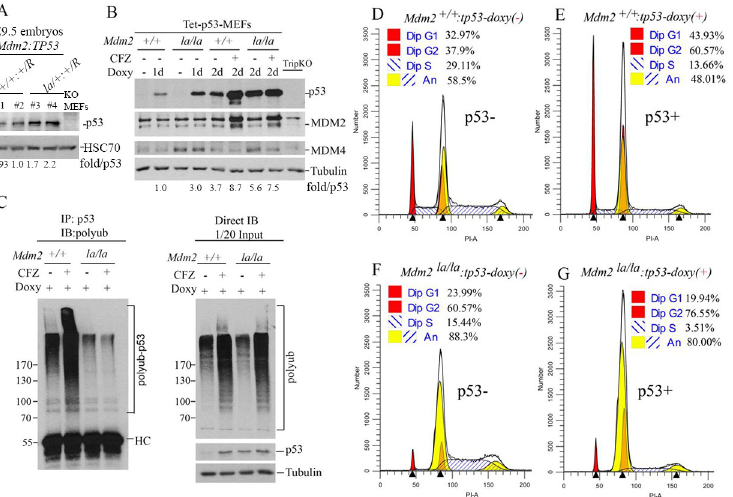
Fig 4. MDM2 E3 ligase activity is required p53-dependent cell cycle regulation in normal growth conditions. ( A ) WB analysis of p53 expression (rabbit polyclonal antibody, Proteintech 10442-1-AP) in four (#1 to #4) E9.5 embryos of Mdm2 +/+ : Trp53 R/+ (#1, #2) and Mdm2 la/+ : Trp53 R/+ (#3, #4) status. Normalized p53 levels shown as fold/p53 after quantification of p53 and HSC70 (loading control) bands by ImageJ and normalized against HSC70. ( B ) WB analysis of p53, MDM2 and MDM4 protein expression levels in Mdm2 +/+ -tetp53 and Mdm2 la/la -tetp53 MEFs. Doxycycline (Doxy, 200ng/ml) was administered for 1 day (1d) or 2 days (2d) with or without further treatment with proteasome inhibitor carfilzomib (CFZ, 400nM) for 8h. p53 -/- /Mdm2 -/- /Mdm4 -/- triple knockout MEFs (TripKO) were used as negative control. Normalized p53 levels against tubulin shown as fold/p53. ( C ) Left panel, Mdm2 +/+ -tetp53 and Mdm2 la/la -tetp53 MEFs were treated with 200ng/ml doxycycline treatment for 24h followed by treatment with or without 400nM CFZ for 8h to assess p53 ubiquitination in cells. Denatured IP was performed with the cell lysates and p53 antibody (DO-1) followed by IB for polyubiquitin (left panel). Right panel, Direct IB for p53 and polyubiquitin and tubulin (loading control) with the same cell lysates are shown (right panel). ( D-to-G ) Cell cycle profiles of Mdm2